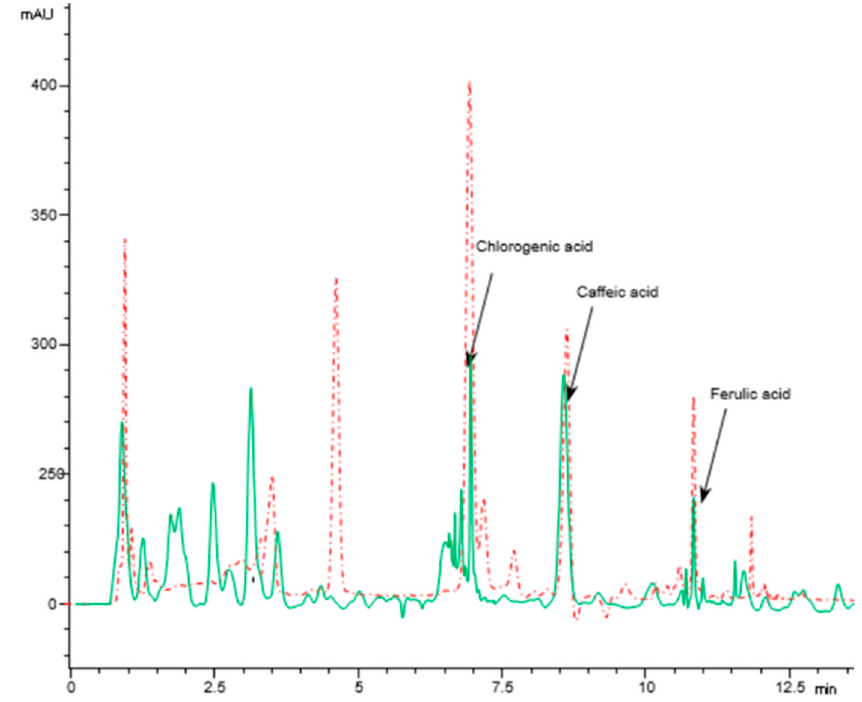
Figure 4. HPLC-DAD chromatograms using the developed method of mixed standards at 216 nm. Red line corresponds to the ethanolic solution of Lysimachia nummularia herba samples with standard solution, blue line corresponds to the ethanolic extracts without standard solution.